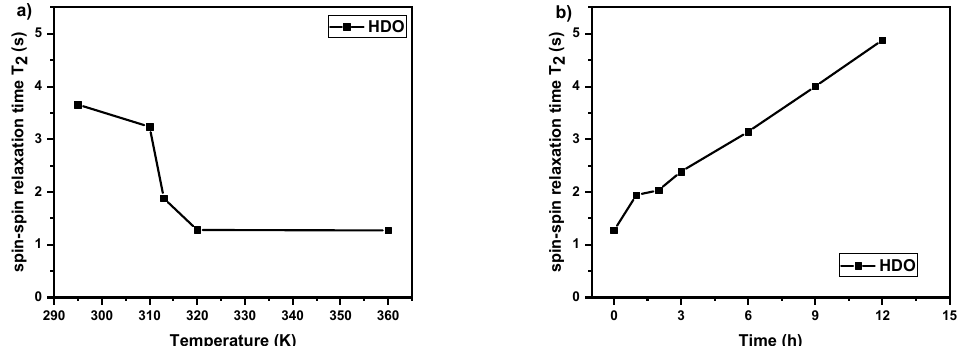
Figure 8. Temperature dependence ( a ) and time dependence at 360 K ( b ) of 1 H spin–spin relaxation times T 2 of HDO in D 2 O solution ( c = 5 wt%) of the PIPOx homopolymer.